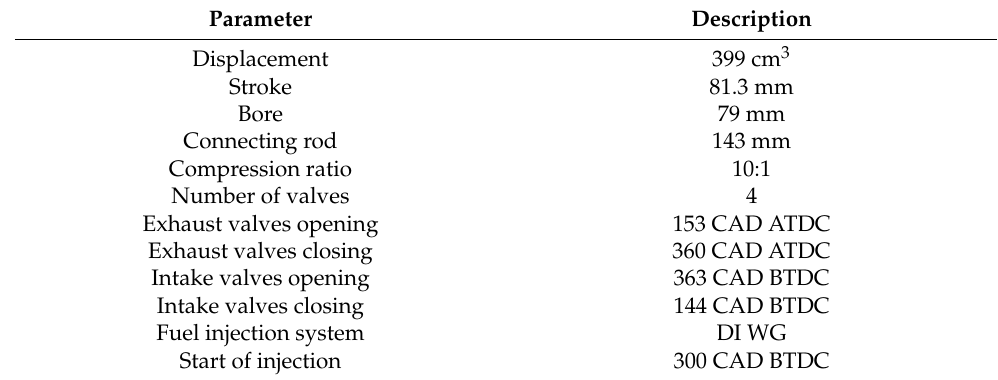
Table 1. Engine specifications.